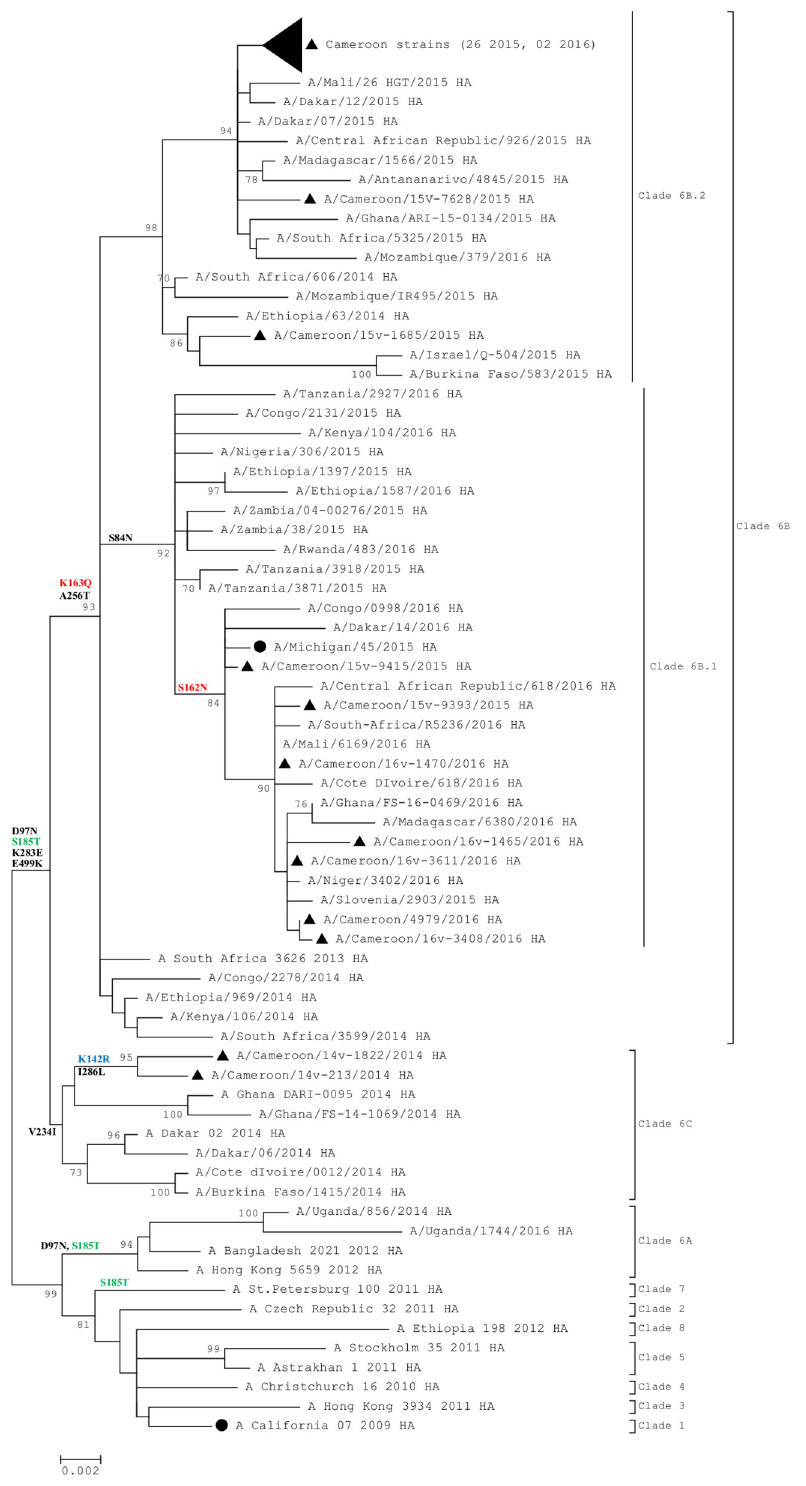
Fig 1. Phylogenetic analysis of HA nucleotide sequences of Influenza A(H1N1)pdm09. ● represents the northern hemisphere vaccine strains recommended by WHO and ▲ represents Cameroon strains. In colour are substitutions in antigenic sites: Ca (blue), Sa (red) and Sb (green). The evolutionary history was inferred by using the Maximum Likelihood method based on the Kimura 2-parameter model. The percentage of trees in which the associated taxa clustered together is shown next to the